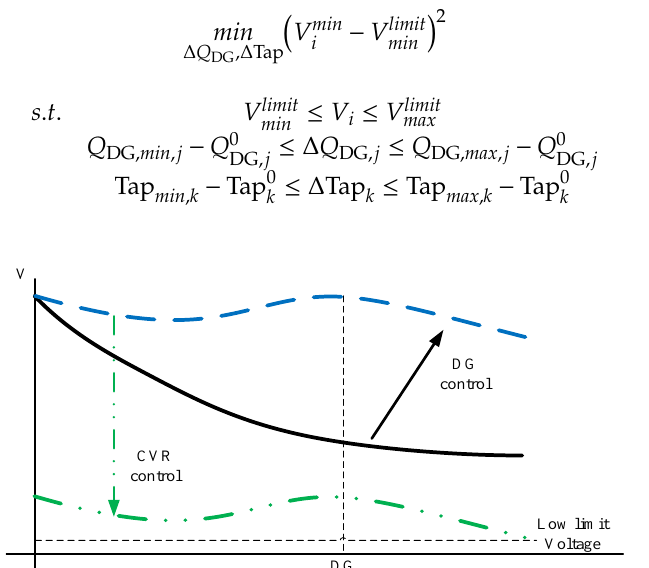
Figure 4. The proposed voltage control method for conservative voltage reduction (CVR).